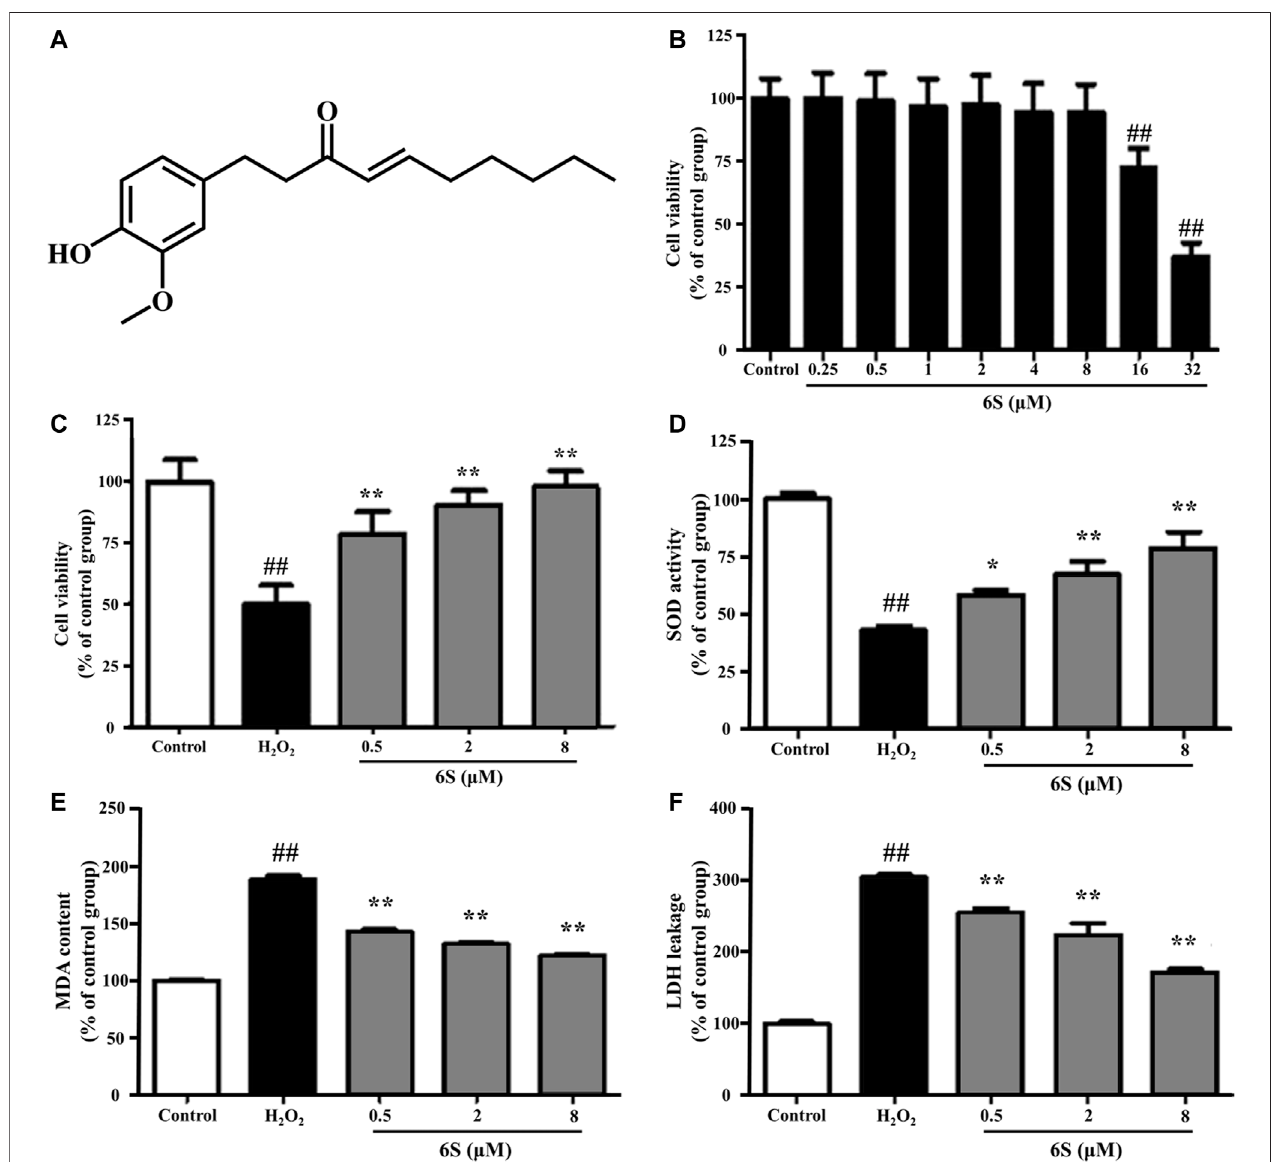
FIGURE 1 | The effect of 6S on cell viability, SOD activity, MDA content, and LDH leakage in VSMCs. (A) Chemical structure of 6S. (B) The cell viability of VSMCs after incubation with 0, 0.25, 0.5, 1, 2, 4, 8, 16, or 32 μ M 6S for 24 h. (C) The cell viability, (D) SOD activity, (E) MDA content, and (F) LDH leakage of VSMCs incubated with 0, 0.5, 2, and 8 μ M 6S for 24 h followed with exposure to 1 mM H 2 O 2 for 2 h. All the data were expressed as mean ± SD ( n ≥ 3). ## p < 0.01 versus control group. ** p < 0.01 versus